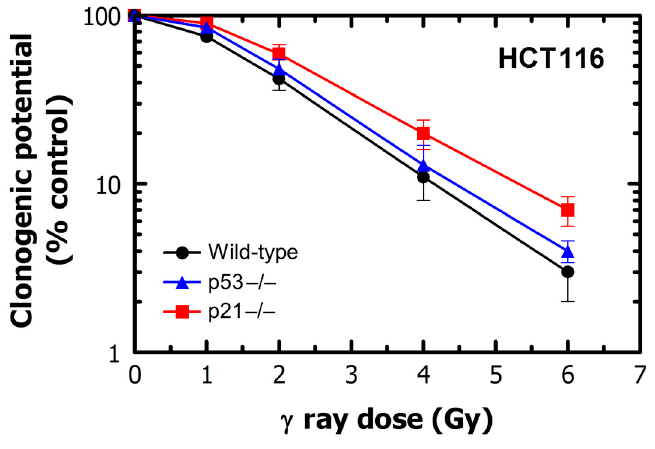
Figure 4. Radiosensitivity of HCT116 wild-type, HCT116p53 − / − and HCT116p21 − / − cultures evaluated by colony formation assay.